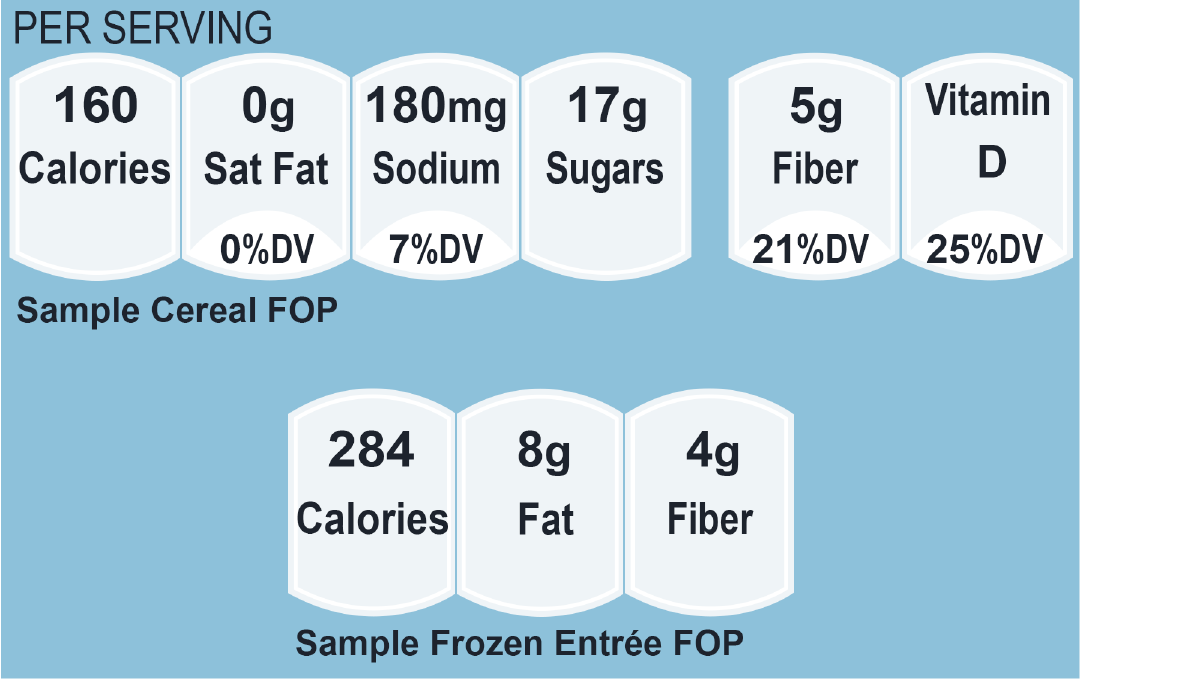
Fig 1. Front-of-Package (FOP) symbols for cereals (top) and frozen entrées (bottom).